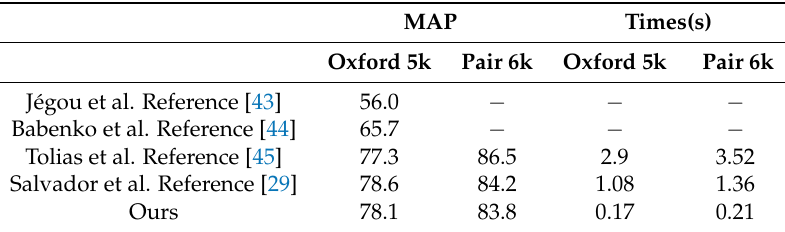
Table 1. Performance comparison with existing methods.